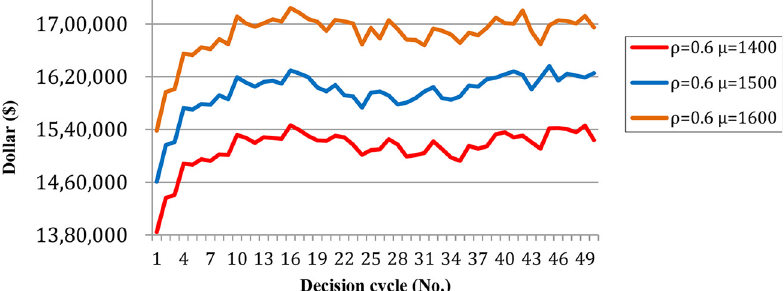
Figure 5. Total cost curves